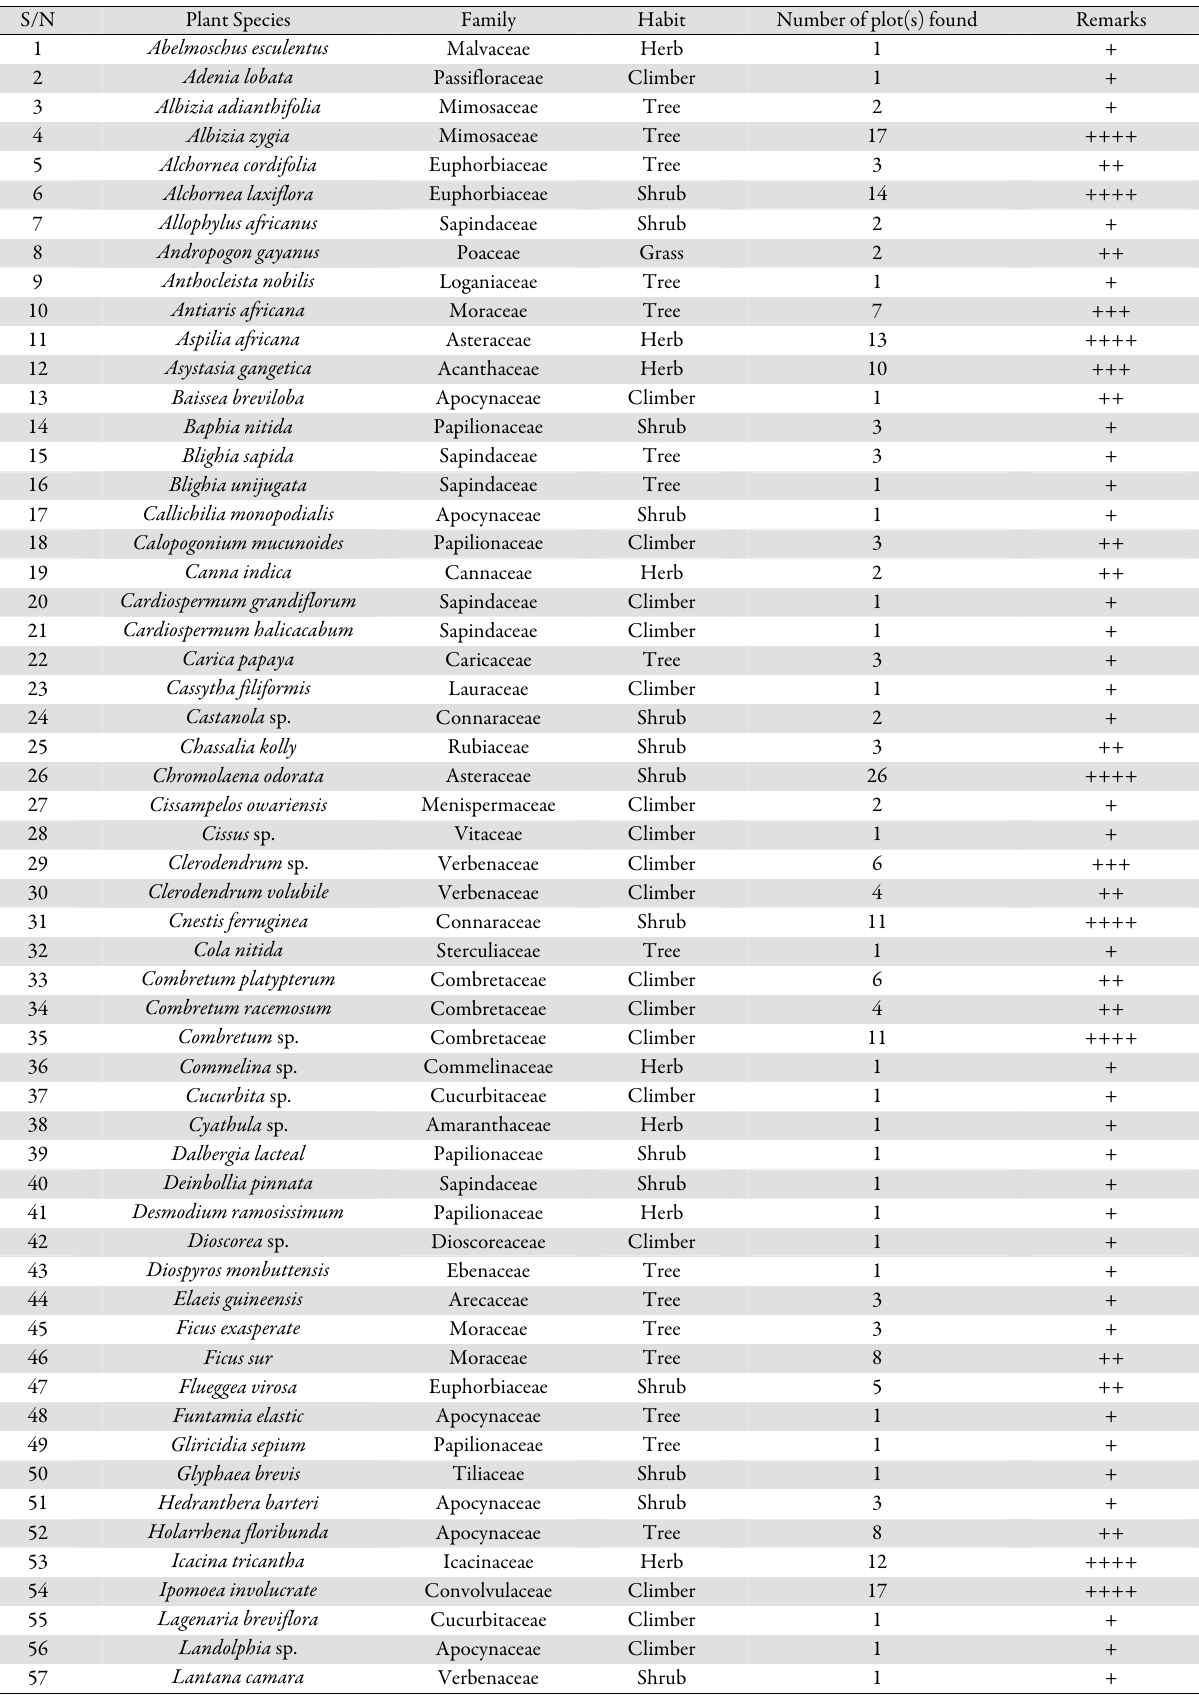
Table 2. Occurrence and status of the plant species in the of study area